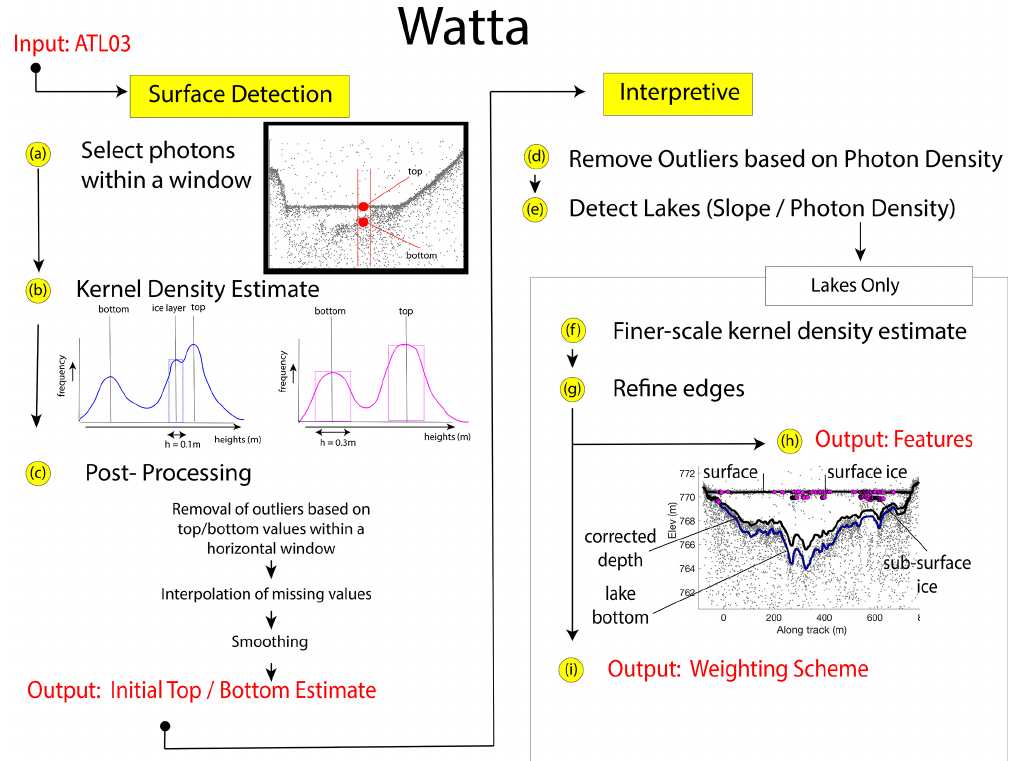
Figure 2. Diagram of the Watta methods described in main